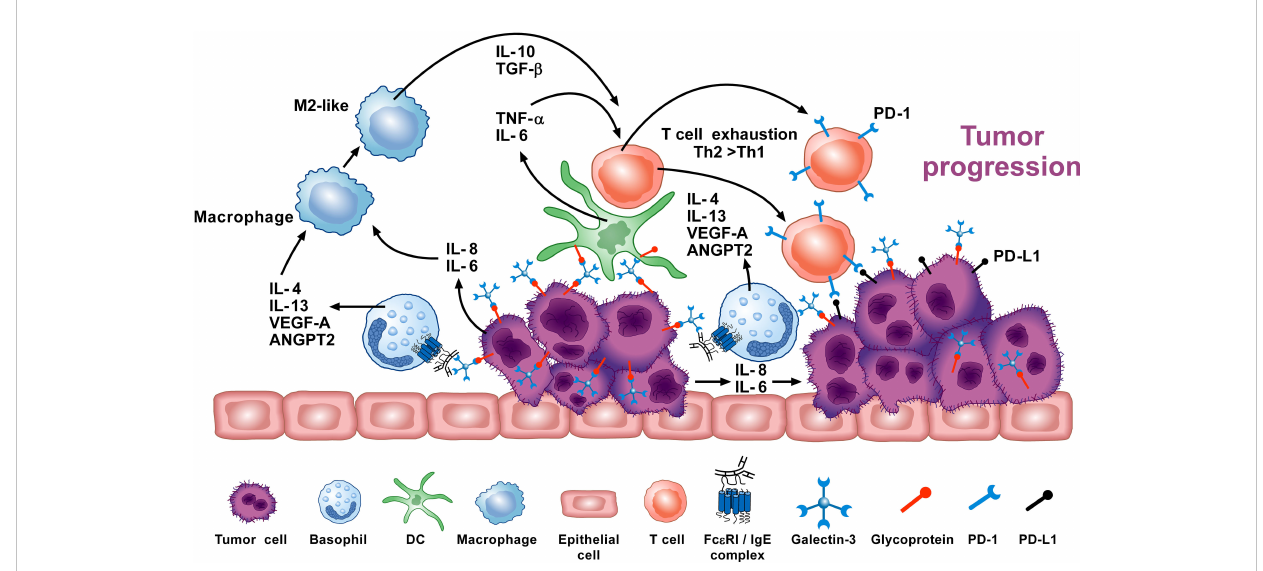
FIGURE 3 Basophils can promote tumor progression through different mechanisms. Galectin-3 (Gal-3) is a lectin expressed by several cancer cells (137), including the A549 adenocarcinoma cell line (EC-Gal-3). Gal-3 activates human basophils to release IL-4 and IL-13 (16, 136), which are widely known to promote M2-like macrophages, the major players in the TME (127 – 130). IL-4 + basophils have been found in the TME of human and experimental pancreatic cancer (72). Human and mouse basophils also secrete VEGF-A and angiopoietin 2 (ANGPT2) that can promote tumor angiogenesis (114, 146 – 148). Basophils can promote IL-6 and IL-8 release from epithelial cell lines through a mechanism requiring cell-to-cell contact (149) (JTS, unpublished). Tumor cell-derived IL-6/IL-8 play a critical role in metastasis formation (150). Dendritic cells and monocytes activated by EC-Gal-3 release TNF- a and IL-6 in vitro (151). These cytokines, combined with M2 cell-derived IL-10 and TGF- b induce T-cell exhaustion by up-regulating checkpoint inhibitors (i.e., PD-1), which interact with tumor cell-associated PD-L1 to decrease cytotoxic T cell activity (152, 153). These results suggest that basophils can promote tumorigenesis in certain experimental and clinical conditions. Adapted from Poto et al.